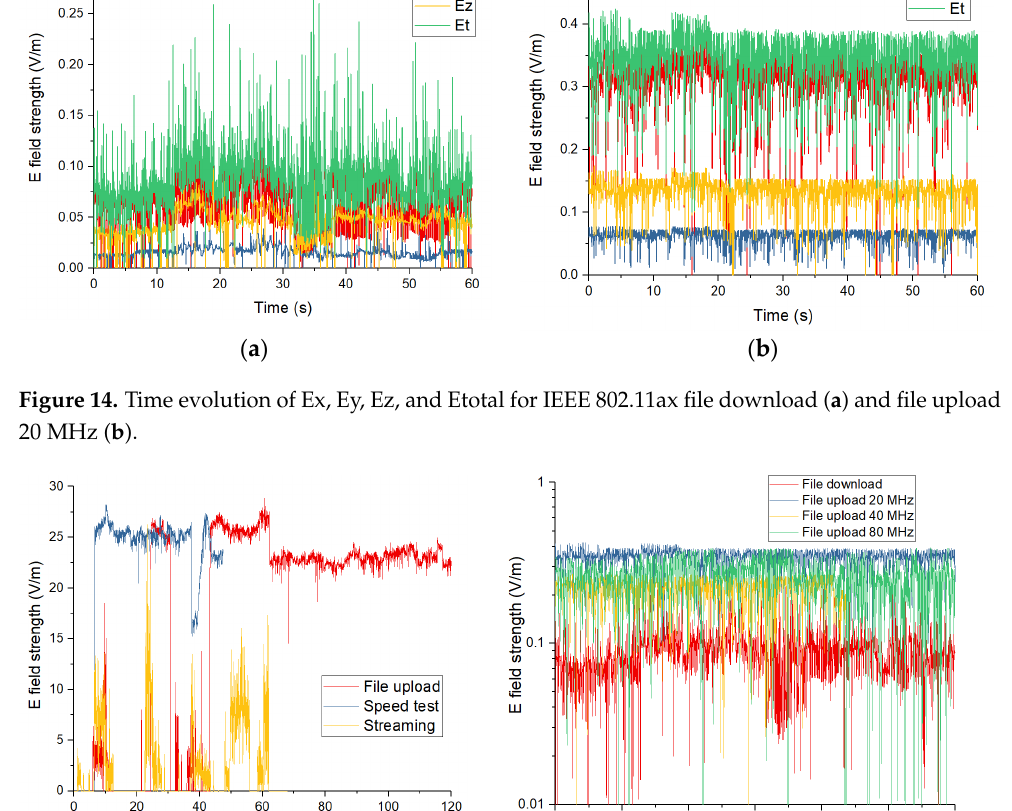
Figure 14. Time evolution of Ex, Ey, Ez, and Etotal for IEEE 802.11ax file download ( a ) and file upload 20 MHz ( b ).